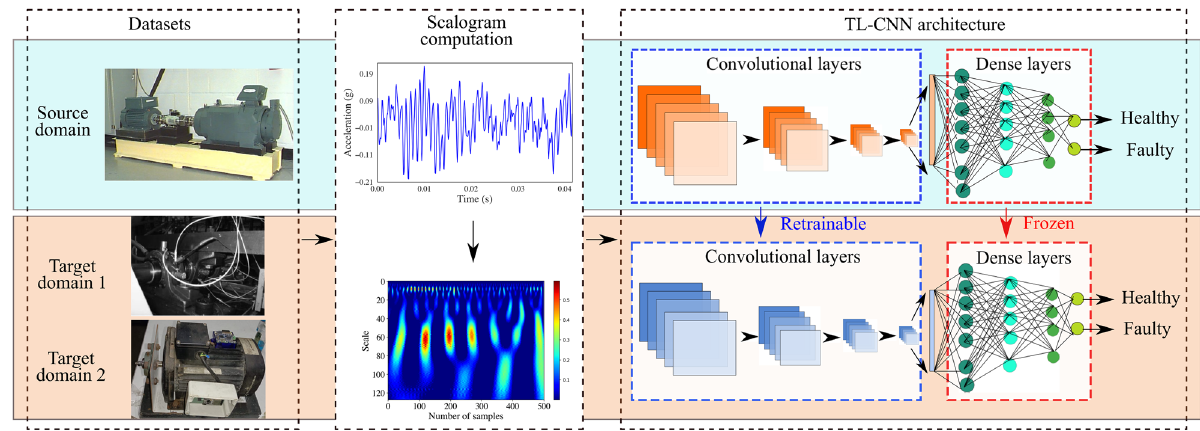
Figure 1. Overview of the TL-CNN architecture presented in this